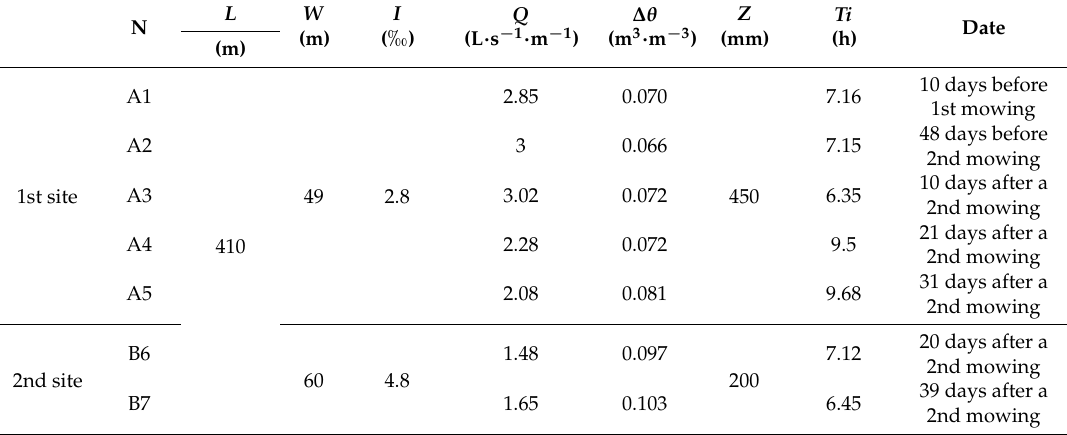
Table 1. Datasets for the monitored experimental irrigations. N is the label of the irrigation, L is the field length, W is the field width, I is the field slope, Q is the irrigation discharge per unit width of the field, ∆ θ is the soil water depletion, Z is the soil depth, Ti is the irrigation duration, Date is the date of the irrigation relative to the mowing date of the